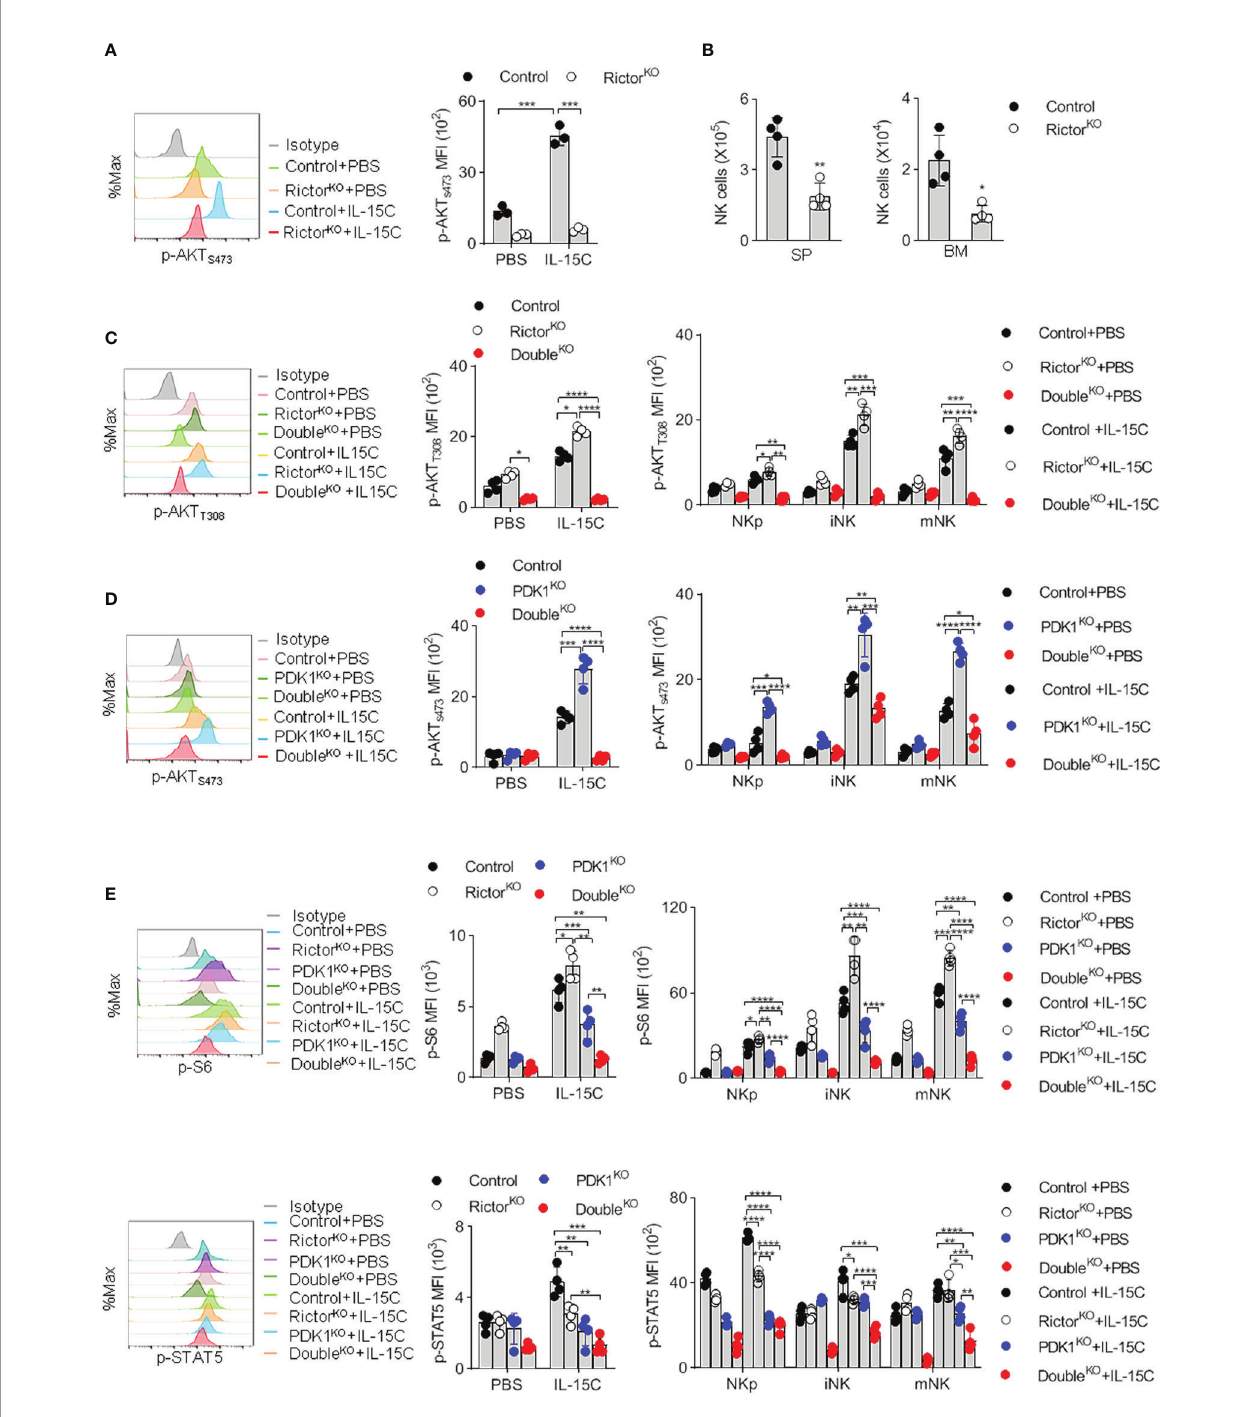
FIGURE 2 | Deletion of Rictor abolishes the enhanced phosphorylation of PKB S473 in PDK1-de fi cient NK cells. (A) The expression levels of p-AKT S473 in Rictor- de fi cient NK cell were detected by fl ow cytometry after IL-15C stimulation. (B) The number of NK cell in the spleen (SP) and bone marrow (BM) of Rictor-de fi cient mice was counted. (C) The expression levels of p-AKT T308 in Control, Rictor-de fi cient or PDK1/Rictor double de fi cient NK cells were detected by fl ow cytometry after IL-15C stimulation. (D) The expression levels of p-AKT S473 in Control, PDK1-de fi cient or PDK1/Rictor double de fi cient NK cells were determined by fl ow cytometry after IL-15C stimulation. (E) The expression levels of p-S6 and p-STAT5 in spleen NK cell were detected by fl ow cytometry after IL-15C stimulation in indicated mice. Representative overlaid histograms (left), absolute MFI (right).The data represent one of three independent experiments, n ≥ 3 for each experiment, and values are expressed as the mean ± SD. *p < 0.05, **p < 0.01, ***p < 0.001, ****p <